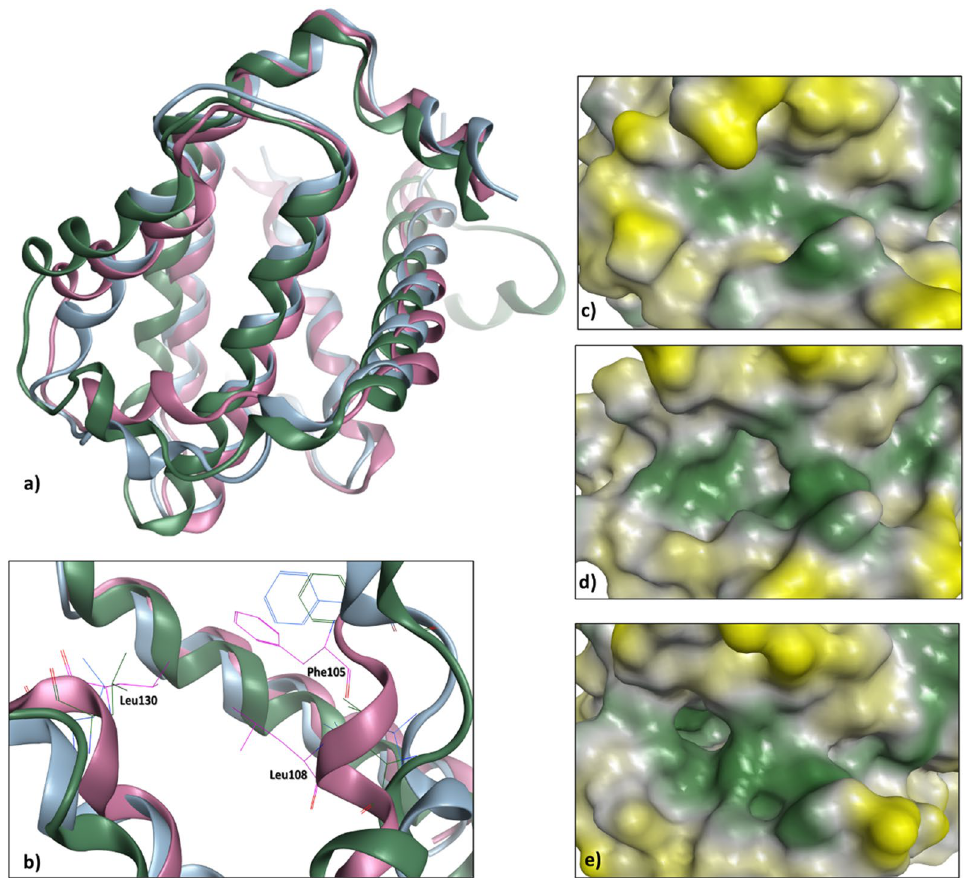
Figure 6. The protein binding interface of three Bcl-xL crystal structures aligned on each other. ( a ) The apo structure is shown as pink ribbons, the peptide-bound structure as blue ribbons and the ligand-bound structure as green ribbons. ( b ) Residues Phe105, Leu108 and Leu130, shown in sticks, represent conformational changes in three Bcl-xL structures. The Bcl-xL interface is clearly showing different topology when comparing ( c ) the apo form (PDB: 1R2E 40 ) with ( d ) the peptide-bound form (PDB: 2BZW 41 ) and ( e ) the ligand-bound form (PDB: 4C52 42 ), where the latter demonstrates the most well-defined pocket, particularly when compared to the apo structure. Notes: Surface color generated using MOE Pocket coloring: green = hydrophobic, yellow = hydrophilic, and grey =